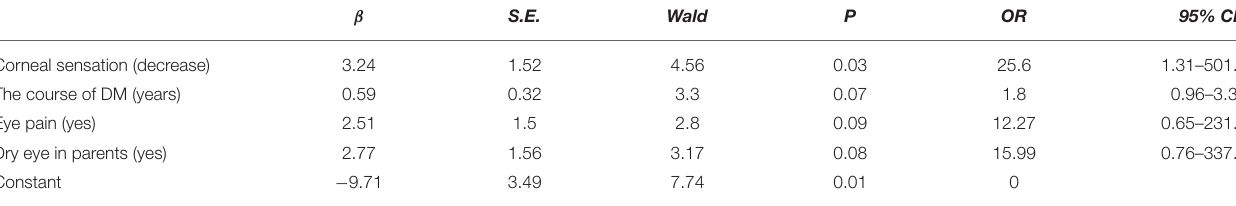
TABLE 4 | Results of multivariate logistic regression analysis for dry eye in children with